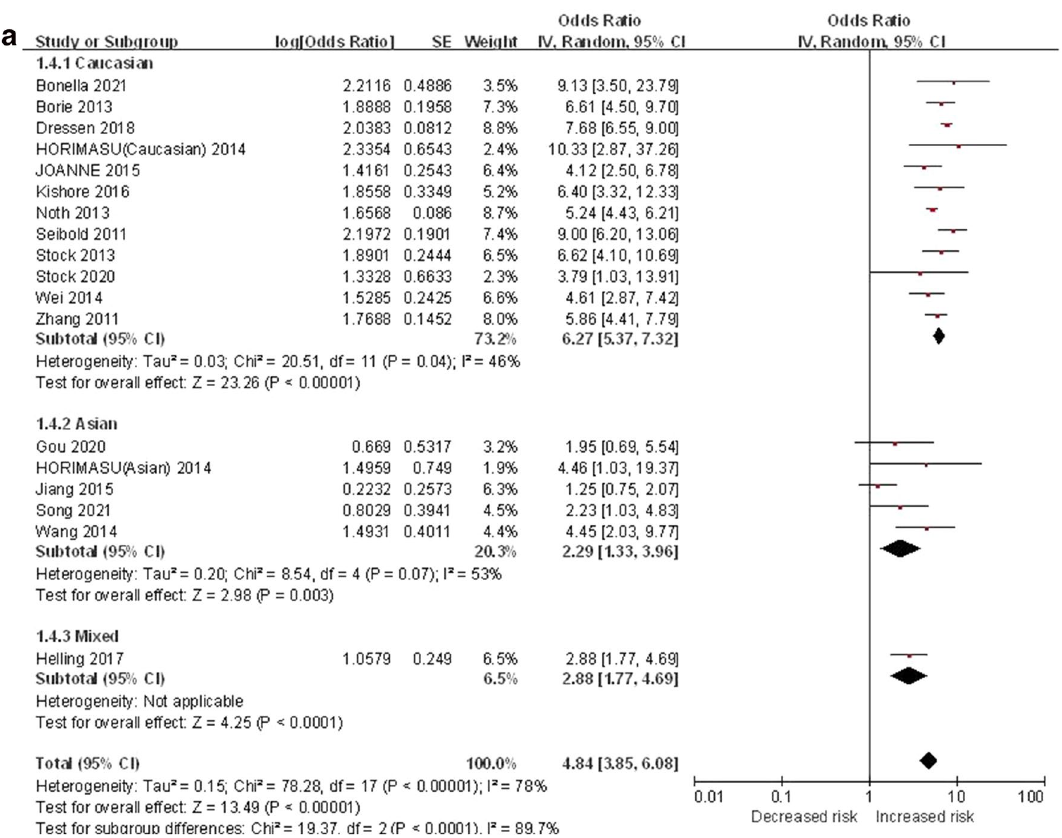
Figure 4. The GT vs. GG model was used to evaluate the correlation between MUC5B gene polymorphism and IPF susceptibility. ( a ) Forest plot of GT vs. GG genetic model. ( b ) Trial sequential analysis of MUC5B polymorphism and IPF risk using the heterozygous genetic model (GT vs. GG) (Adjusted Boundaries Print). Although the combined sample size (N = 12,737) did not exceed RIS (N = 53,898), the cumulative Z curve crossed the conventional boundary and the TSA boundary, and the association was established in advance. ( c ) Inverted funnel chart of GT vs.